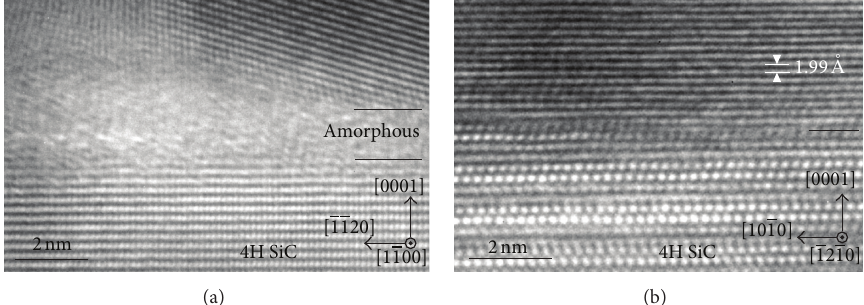
Figure 9: Cross-sectional high-resolution TEM images of interfacial region between the 4H-SiC substrate and the Ni-silicide after annealing at 600 ∘ C (a) and subsequently at 1050 ∘ C (b) [71].